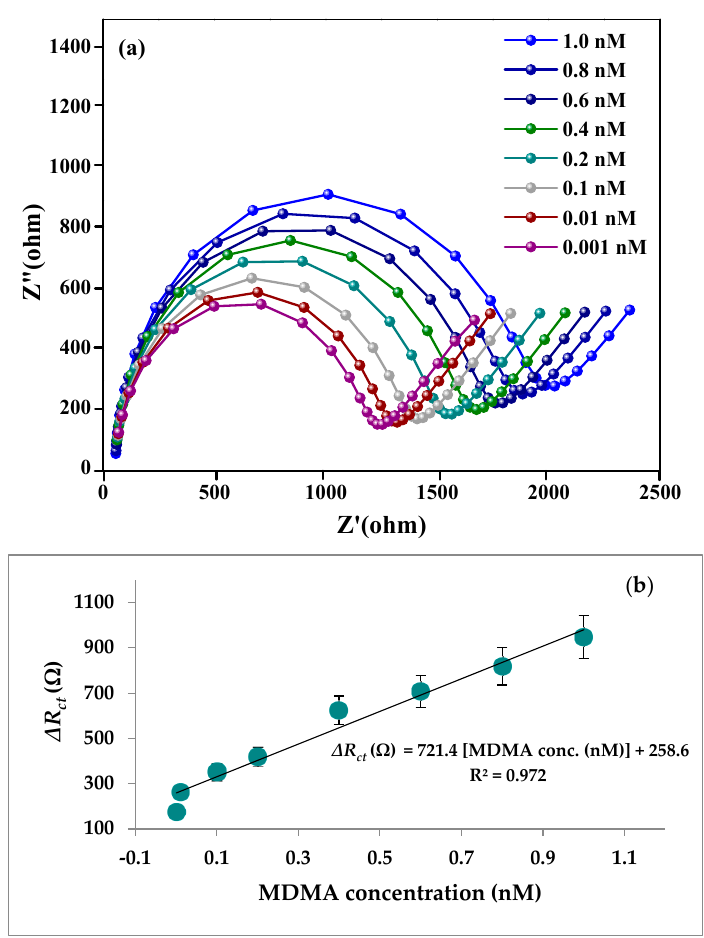
Figure 9. Performance analysis of Apt MDMA /SnNPs@Au electrode at different (±)-3,4-Methylenedioxymethamphetamine (MDMA) concentrations. ( a ) Change in charge transfer resistance ( Δ R ct ) at MDMA concentrations of 0.001, 0.01, 0.1, 0.2, 0.4, 0.6, 0.8, and 1.0 nM. Analyses were carried out in 5.0 mM [Fe(CN) 6 ] 3 − /4 − and 0.1 M KCl electrolyte. ( b ) Calibration curves between Δ R ct and different MDMA concentrations.